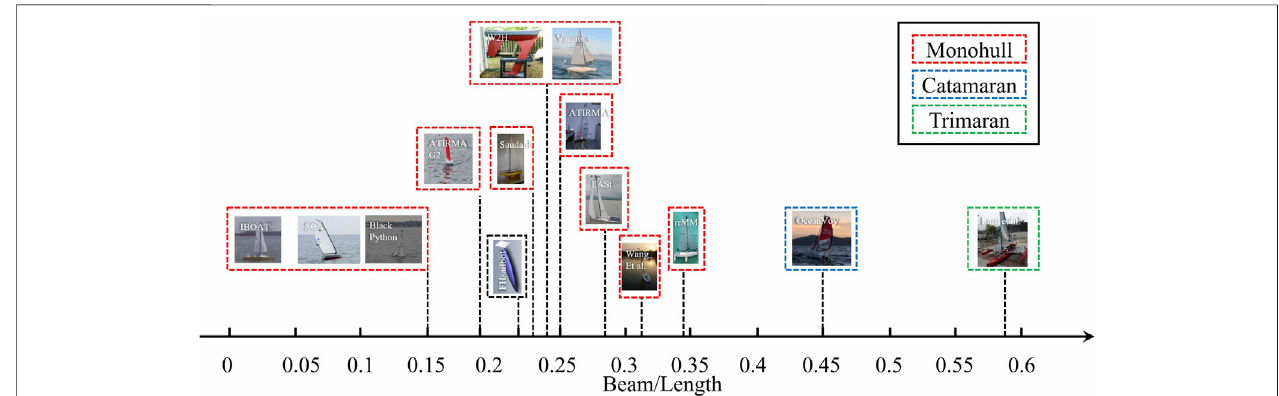
FIGURE 8 | Beam-length ratio of